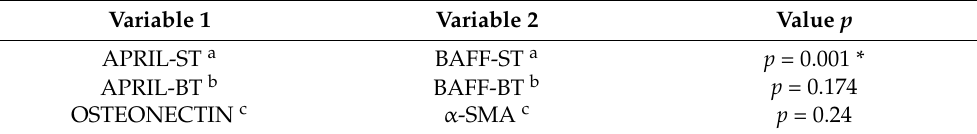
Table 5. Relationship of variables APRIL-ST/BT, BAFF-ST/BT, osteonectin, α -SMA. Variable 1 Variable 2 Value